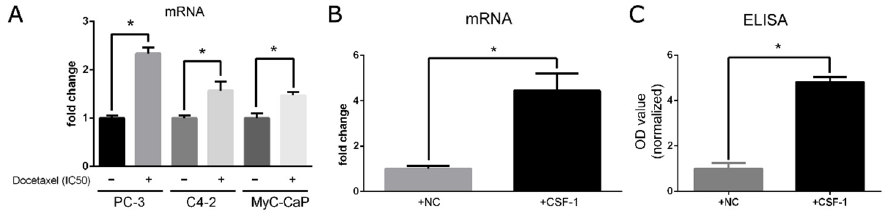
Figure 1. Docetaxel treatment for 48 h induces the upregulation of CXCR4 in prostate cancer cells and CXCL12 in macrophages. ( A ) CXCR4 was upregulated upon treatment with docetaxel in PC-3, C4-2, and MyC-CaP cells via qRT-PCR. ( B ) CXCL12 was increased when RAW cells were stimulated by CSF-1 as examined via qRT-PCR. ( C ) ELISA confirmed the increased secretion of CXCL12 when stimulated by CSF-1 in RAW cells. All experiments were repeated three times. *: p <